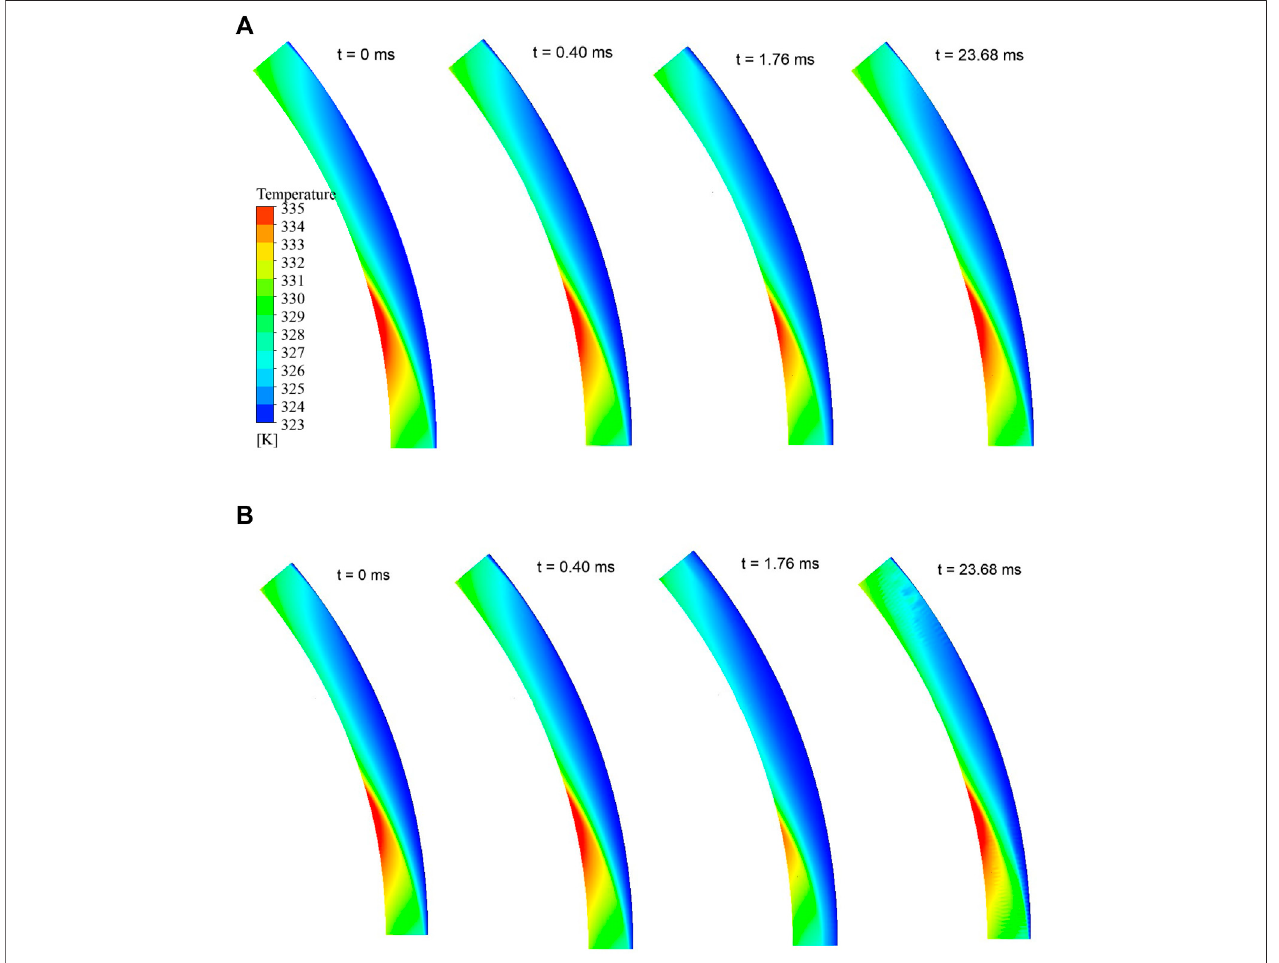
FIGURE 13 | Temperature distribution varies with time (A) a = 4% and (B) a = 10%.